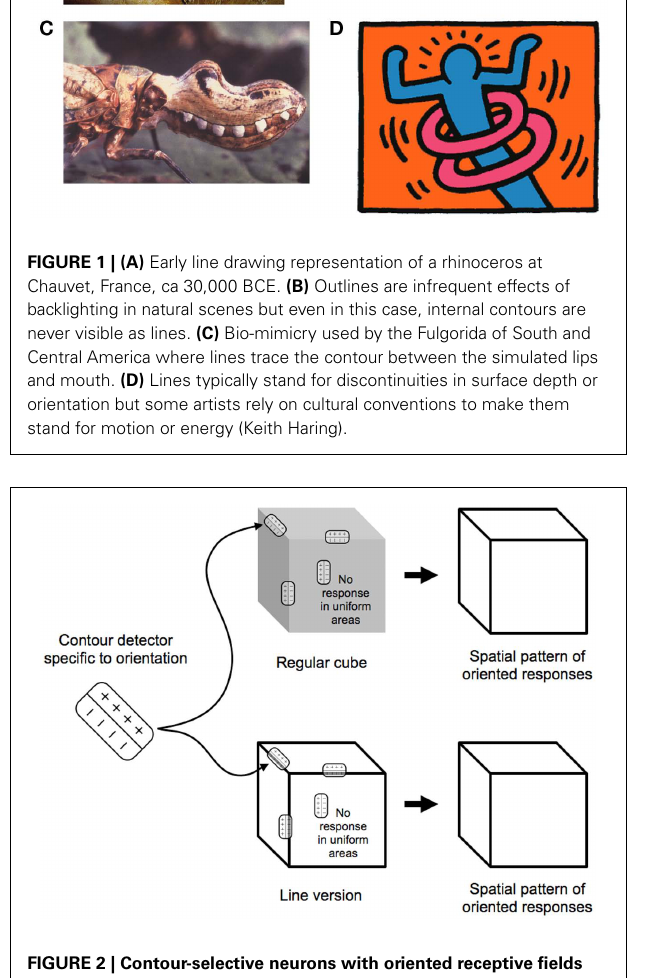
FIGURE 2 | Contour-selective neurons with oriented receptive fields fire along the contours of the cubes. The analysis of both types of cubes yields the internal sketch-like representation of the cube, which would, in actuality, be distorted by the cortical magnification.